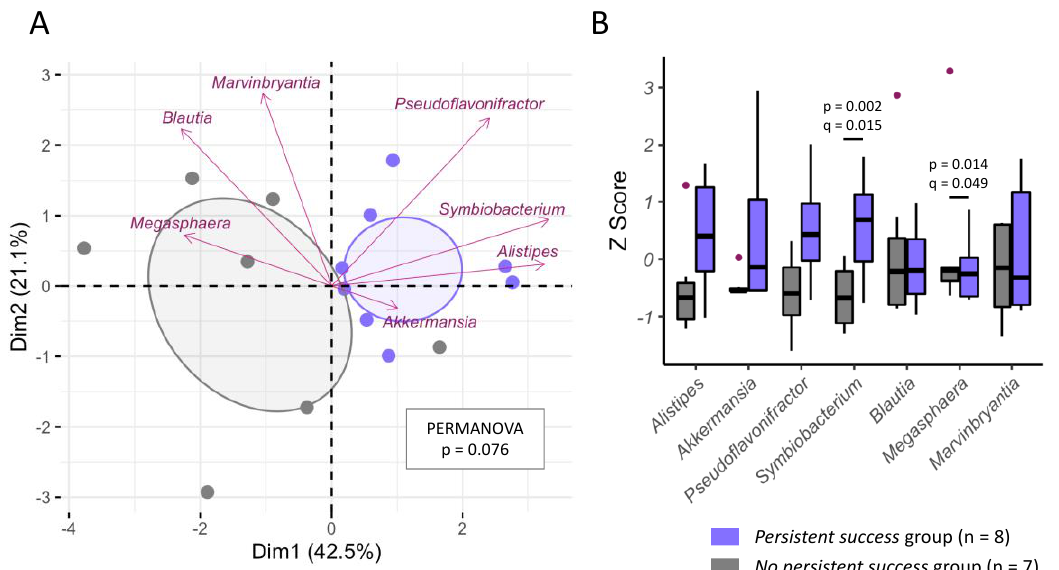
Figure 1. Microbial differences between individuals from the persistent success and the nonpersistent success groups on genus level. ( A ) This principal component analysis plot shows the 7 weight-loss predictive genera as well as the 15 individuals, color-coded by their persistent/nonpersistent weight loss status. Distances between the dots (representing individuals) were computed by the Euclidean index on centered-log ratio transformed data of the seven weight-loss predictive genera presented in Table 5. Dim, dimension/principal component; PERMANOVA, permutational multivariate analysis of variance. ( B ) Boxplots showing the comparisons of bacterial abundance (Z score) between the two groups for each genus using Mann – Whitney U tests with the respective p -values being adjusted with the false discovery rate method (q-value). Only comparisons with q < 0.1 are shown.